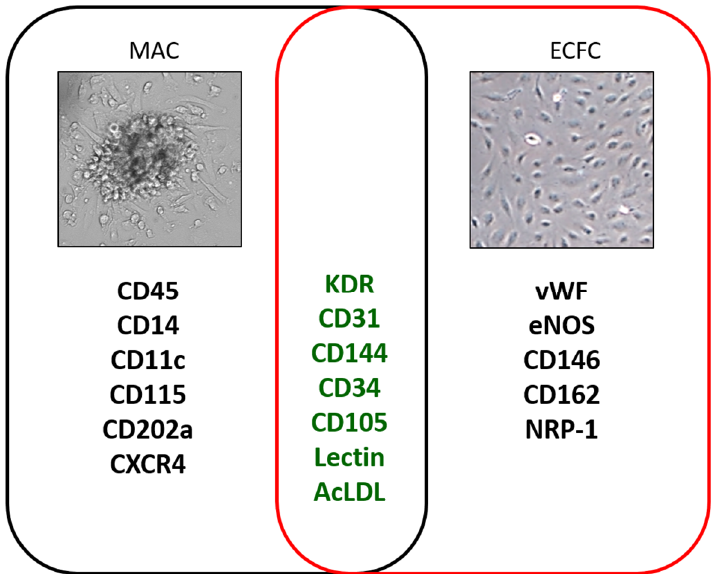
Figure 1. Cluster differentiation (CD) and other markers that identify myeloid angiogenic cells (MACs), black left circle, and endothelial colony forming cells (ECFCs), red right circle. The markers shared by both cell populations are in the center. Cluster domain (CD); CXC motif, receptor 4 (CXCR4); kinase insert domain receptor (KDR); acetylated low-density lipoprotein (acLDL); Von Willebrand factor (vWF); endothelial nitric oxide synthase (eNOS); Neuropilin-1 (NRP-1).